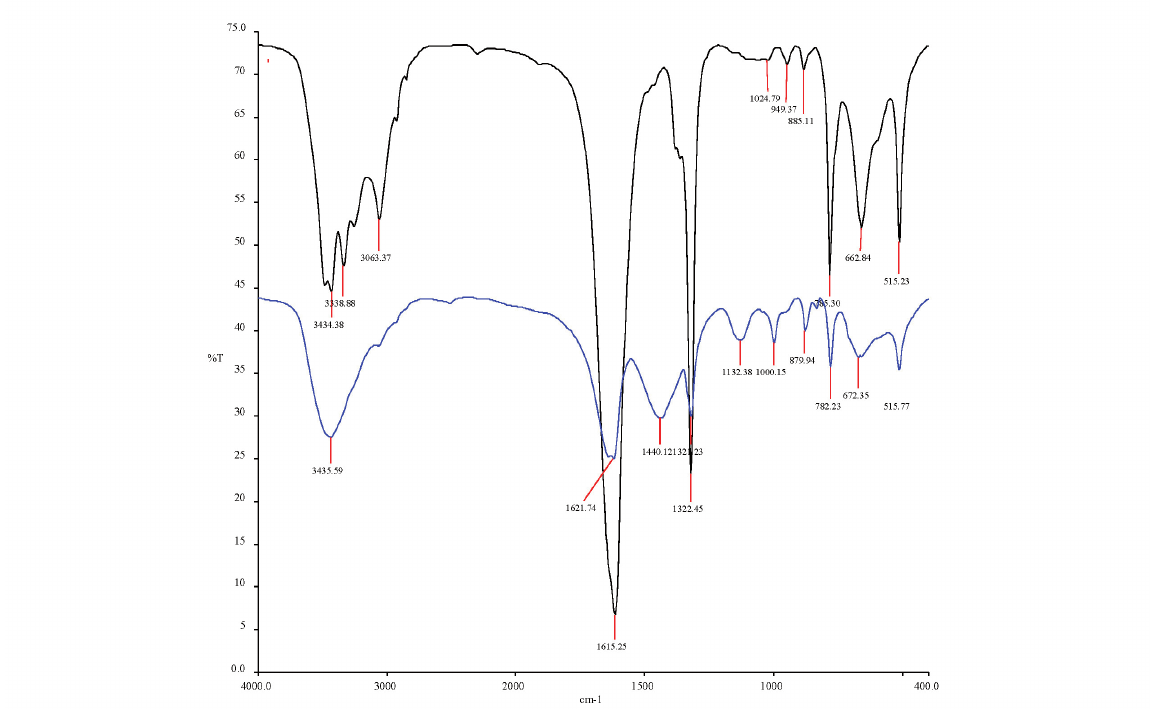
Figure 2 - FTIR spectral data of calcium oxalate obtained in the absence (above) and presence (below) of